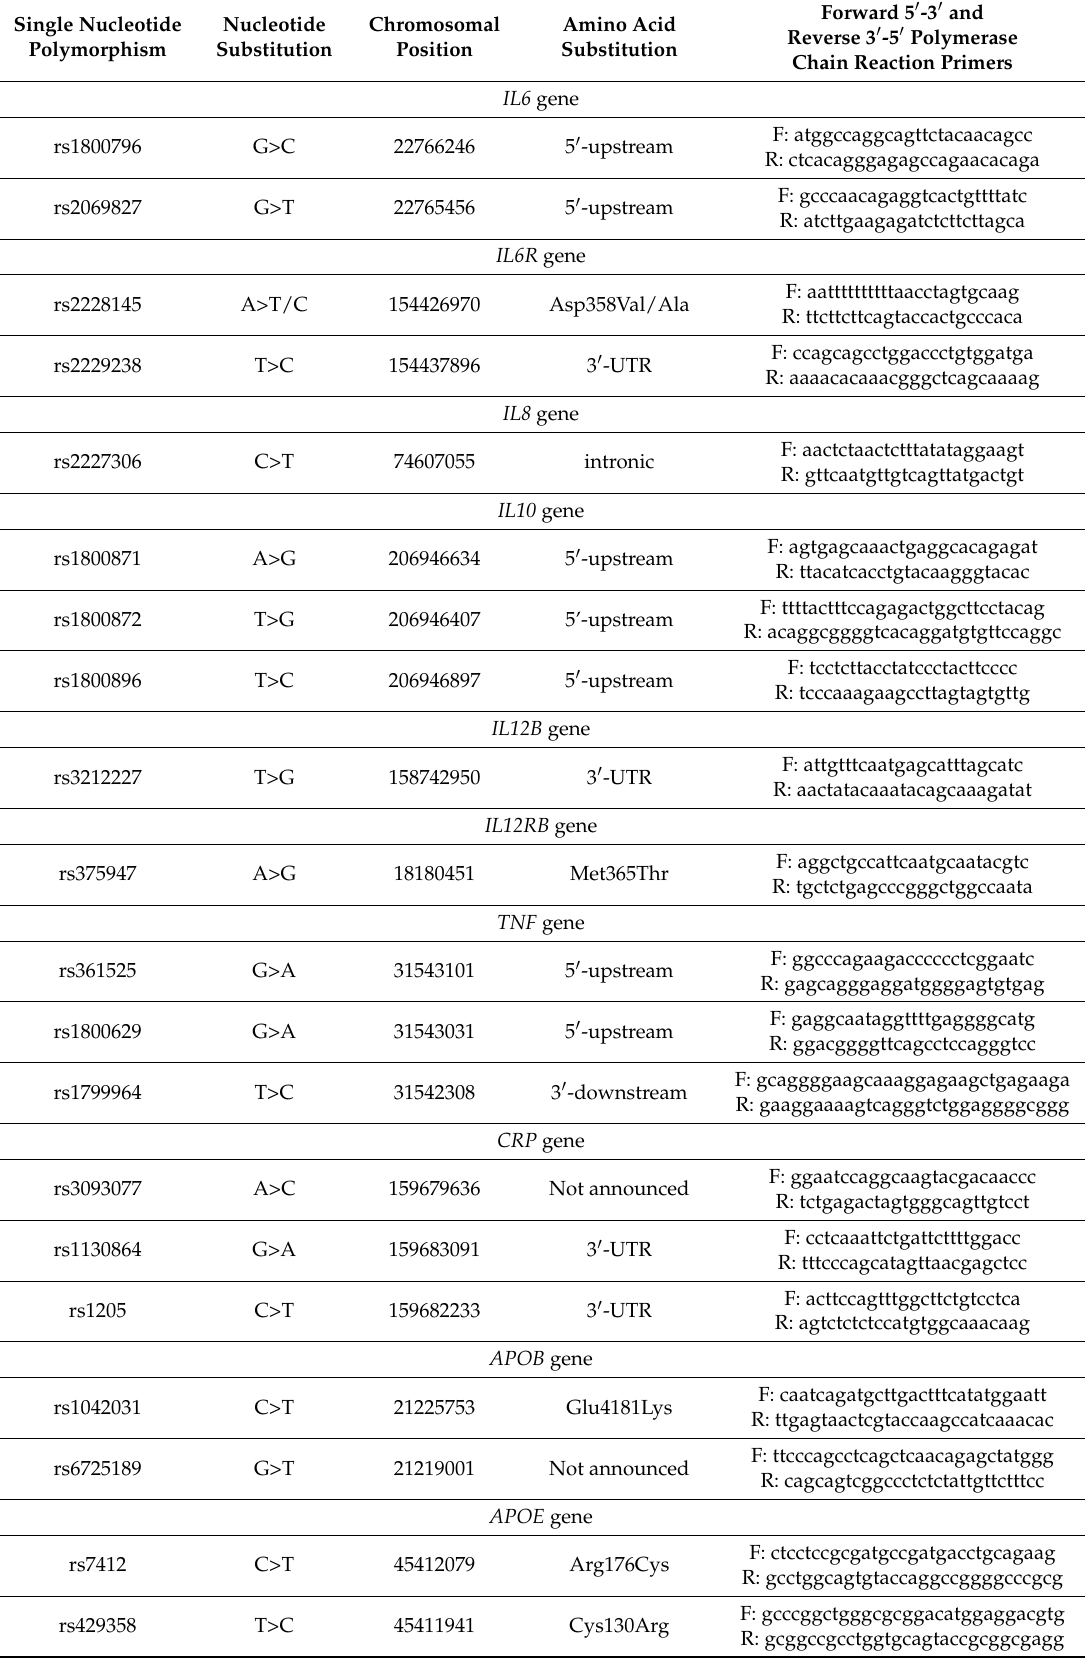
Single Nucleotide Polymorphism